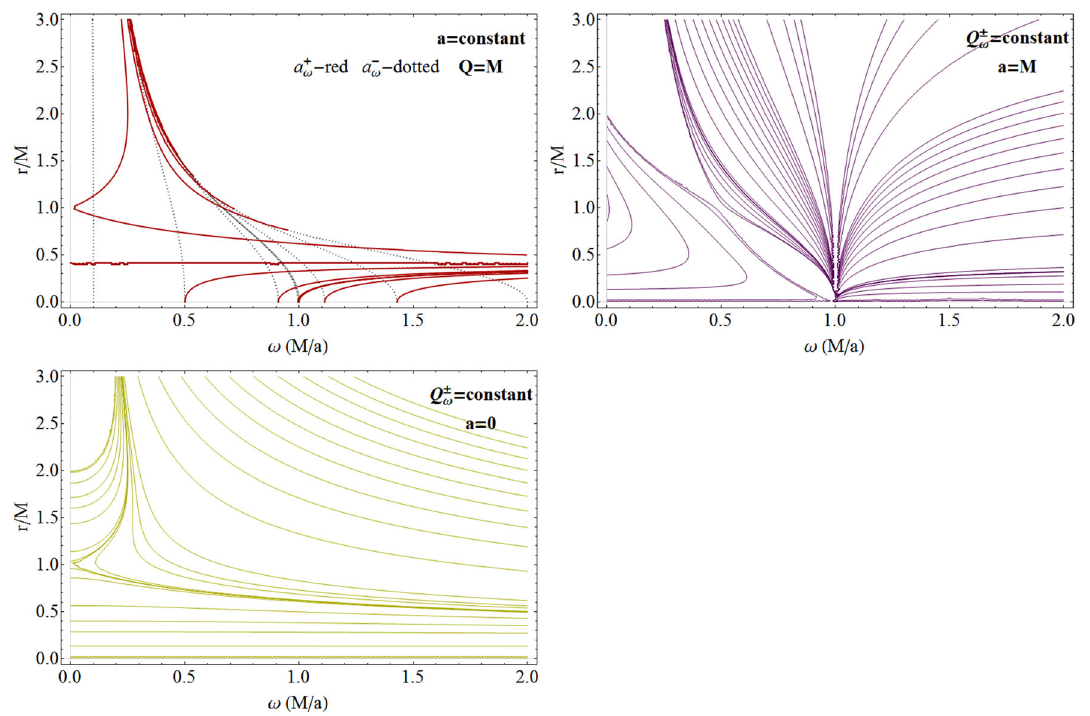
Fig. 21 Equatorial plane of the Kerr–Newman spacetimes. The frequencies ω ± = constant, charge Q ± ω = constant, and spins a ± ω = constant for some limiting cases – Eq. (37)